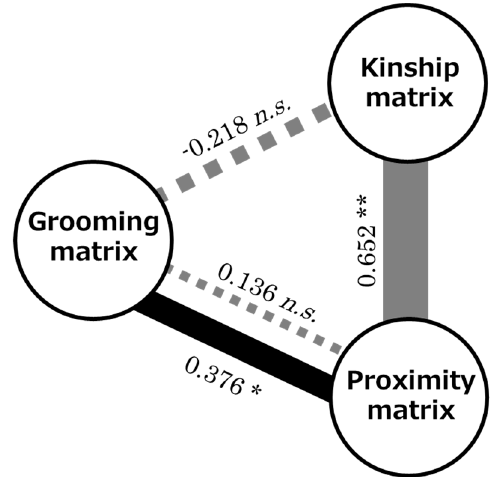
Figure 2. Correlation diagram of the matrices. Solid gray lines and the boldness indicate significant matrix rank correlations and coefficients (Tau Kr ), respectively, dotted lines indicate non-significant correlations, and black lines and the boldness indicate partial correlations and coefficients, respectively. The respective coe ffi cients are shown above the line. * indicates p < 0.05 and ** indicates p < 0.01. n. s. denotes a nonsignificant ( p > 0.05).